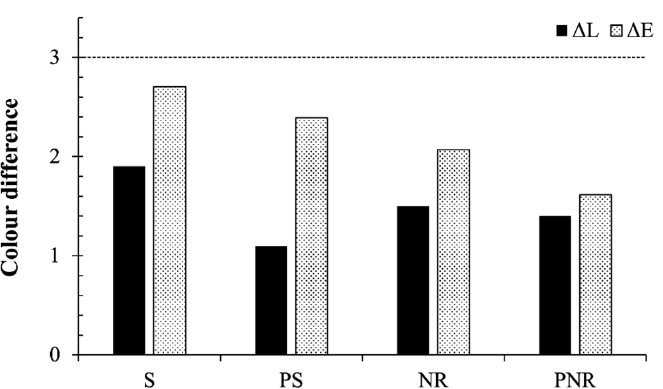
Figure 4. Colour difference between M0 and M24.